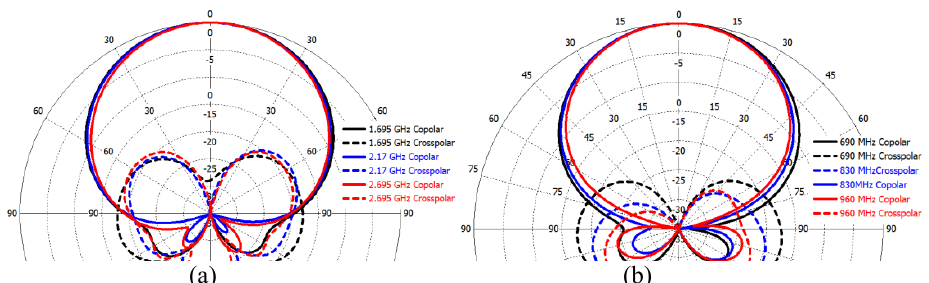
Fig. 4. Results of simulations co-polar and cross-polar patterns at horizontal plane of described dual- polarized antennas, (a) crossed dipole 1695-2695 MHz, (b) square dipole 690-960